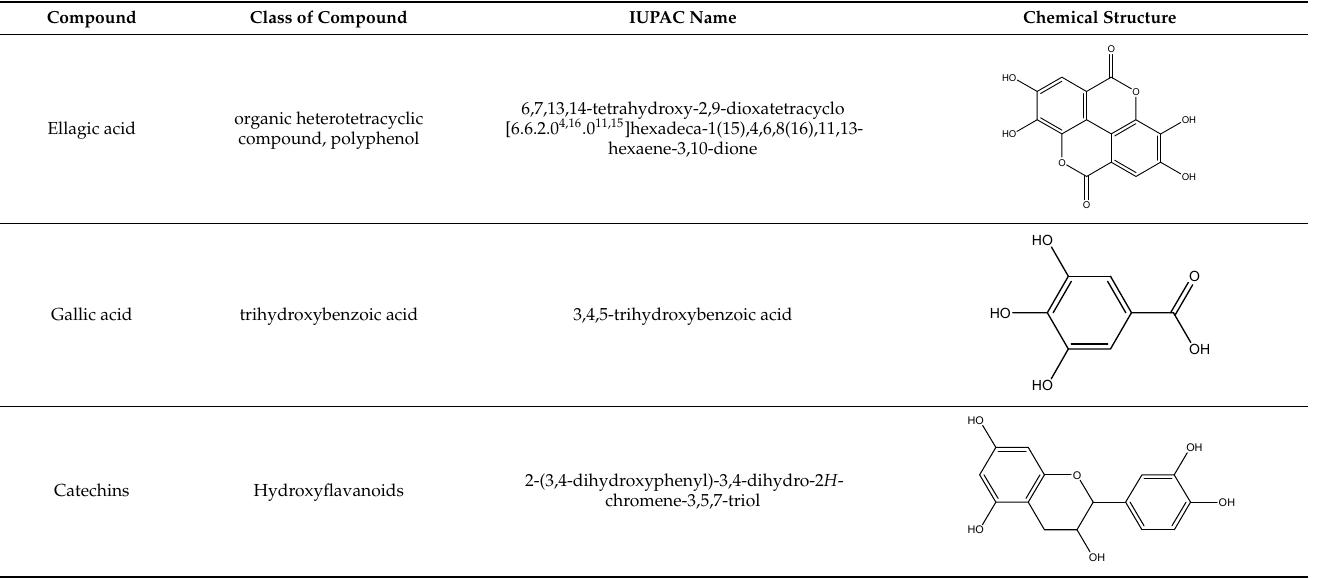
Table 2. Chemical structure of bioactive molecules isolated from L. tridentata from the International Union of Pure and Applied Chemistry (IUPAC).